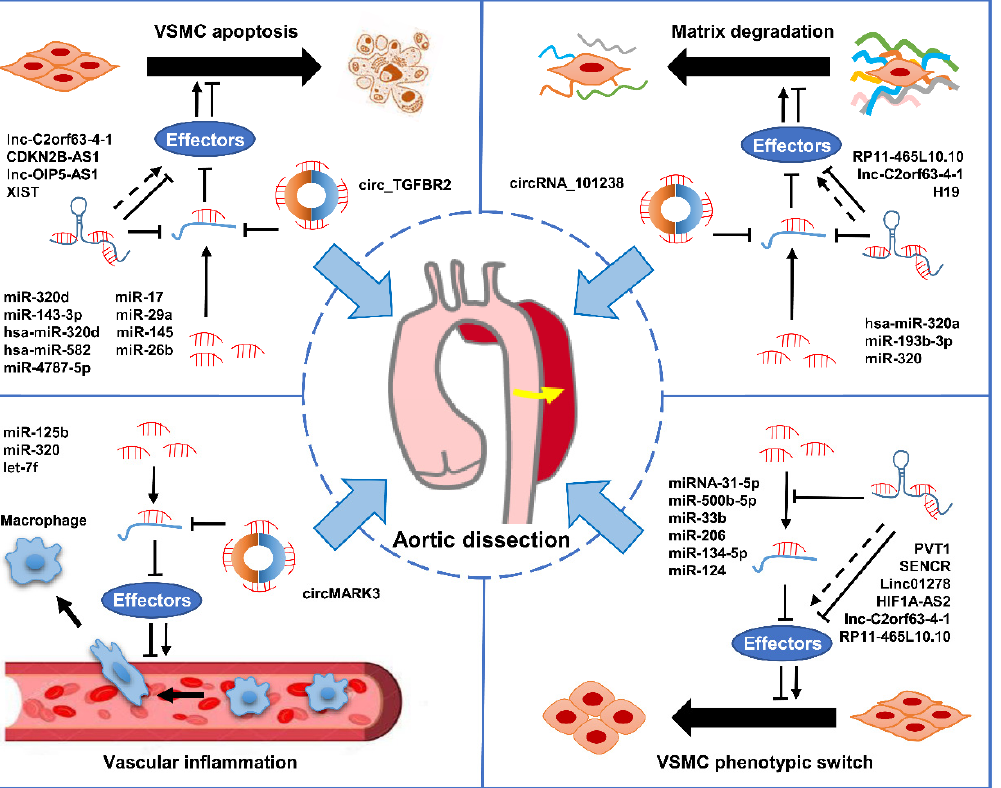
Figure 2. The mechanisms of ncRNAs involved in AD progression. The dysregulation of miRNAs, lncRNAs, and circRNAs contributes to AD progression by modulating crucial biological progresses, including phenotypic transformation and apoptosis of VSMCs, extracellular matrix degradation, and vascular inflammation.